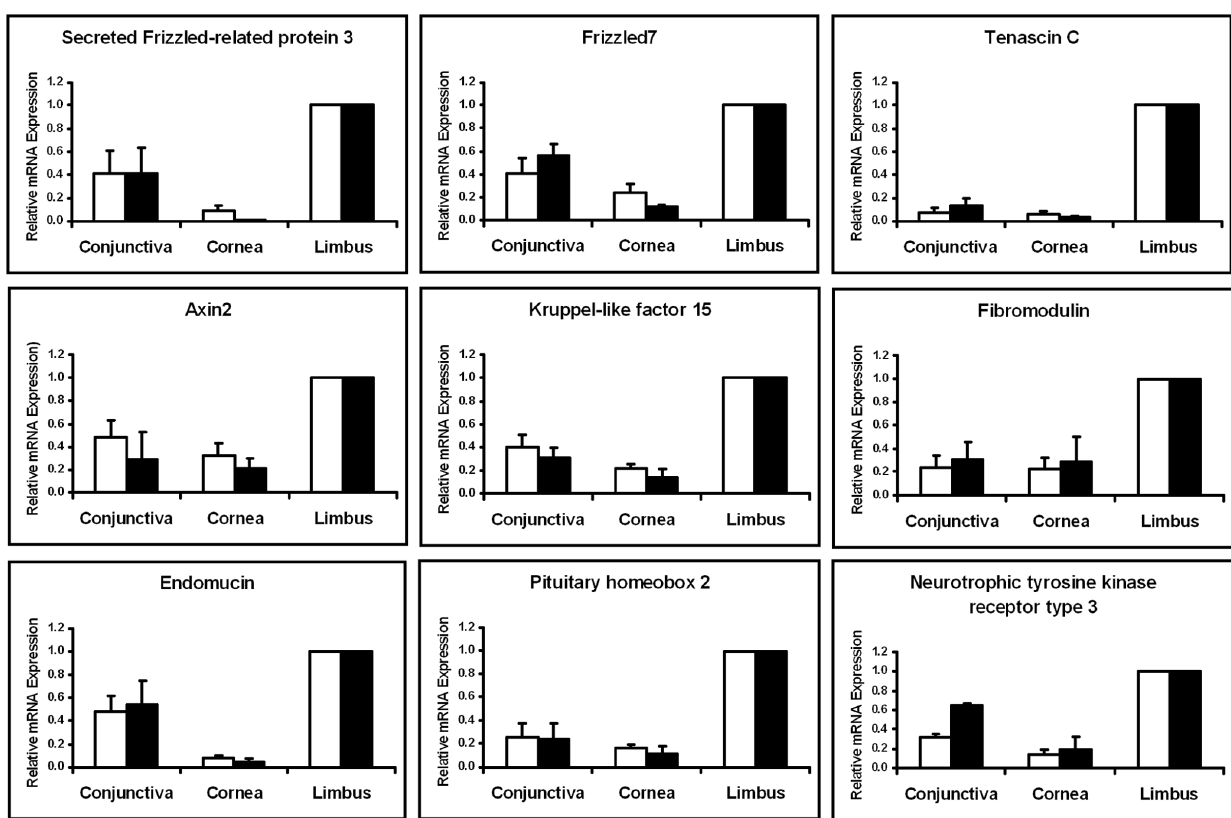
Figure 3. Comparison of mRNA expression levels between microarray and qRT-PCR of selected transcripts. All 9 transcripts were preferentially expressed in the limbus and minimally expressed in the cornea and conjunctiva. White bars represent the microarray results and black bars represent the qRT-PCR results. Similar expression patterns were observed between the microarray and qRT-PCR.